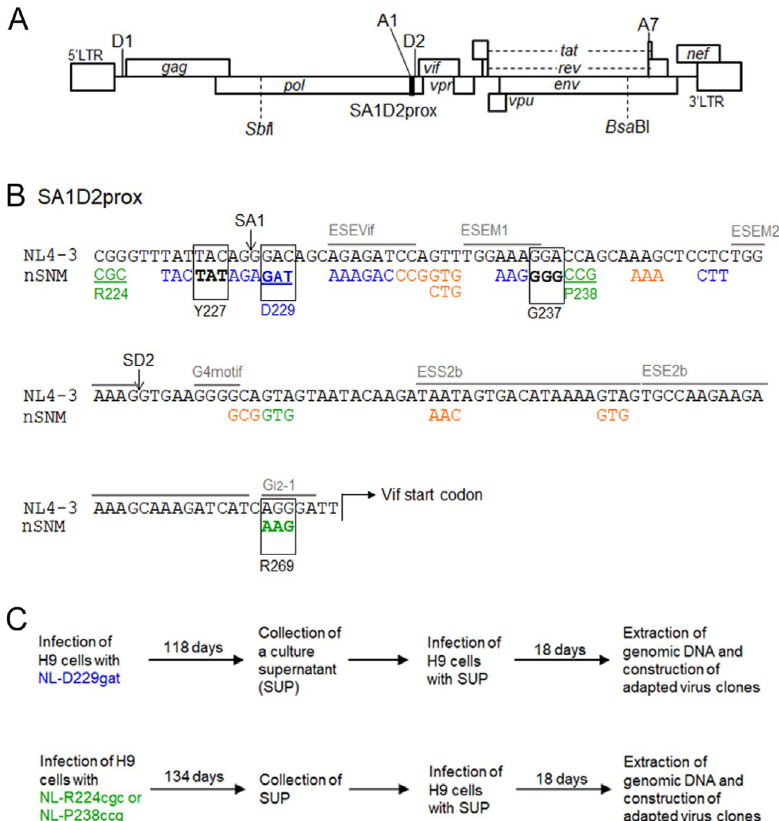
Figure 1. SA1D2prox sequence on the HIV-1 genome and virus adaptation procedure. ( A ) HIV-1 (NL4-3) genome organization. The SA1D2prox region is shown by a black box. Some of the splicing sites (SD1, SA1, SD2, and SA7) of the HIV-1 genome are indicated. Unique restriction enzyme sites ( Sbf I and Bsa BI) used to make adapted viral clones are indicated. ( B ) SA1D2prox sequence. Sequences of low (NL-D229gat) and excessive (NL-R224cgc and NL-P238ccg) Vif types used for the adaptation experiments in this study are shown by blue and green letters/lines, respectively. Blue, orange, and green letters without underlines indicate single-nucleotide mutants identified by us [37–39] which display low, high, and excessive Vif types, respectively. Boxed, bold letters show adaptive mutations that change the Vif expression levels identified in this study. Splicing sites (SA1 and SD2) are indicated. Several known splicing enhancer/silencer motifs are represented by gray letters and lines [18–21], (for review, see [16]). nSNM, naturally-occurring single nucleotide mutation. ( C ) Virus adaptation. Viral clones of low (NL-D229gat) and excessive (NL-R224cgc and NL-P238ccg) Vif types were inoculated into H9 cells and cultured for the indicated periods. Fresh H9 cells were infected with the SUP collected on day 118 for NL-D229gat and day 134 for NLR224cgc/NL-P238ccg. On viral